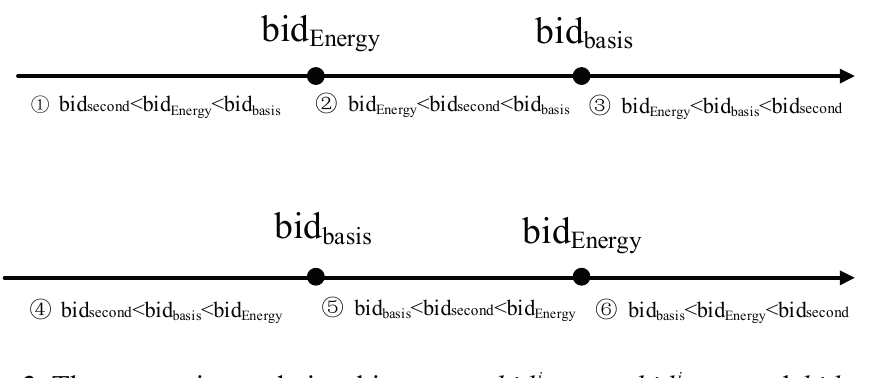
Figure 3. The comparison relationship